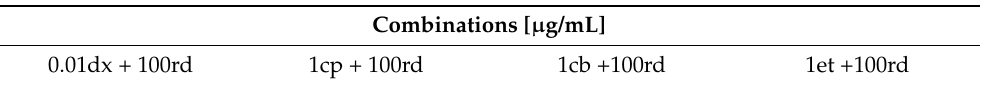
Table 2. Concentrations selected for the assessment of apoptosis. dx-doxorubicin, cp-cisplatin, cb-carboplatin, et-etoposide, rd-risedronate sodium.